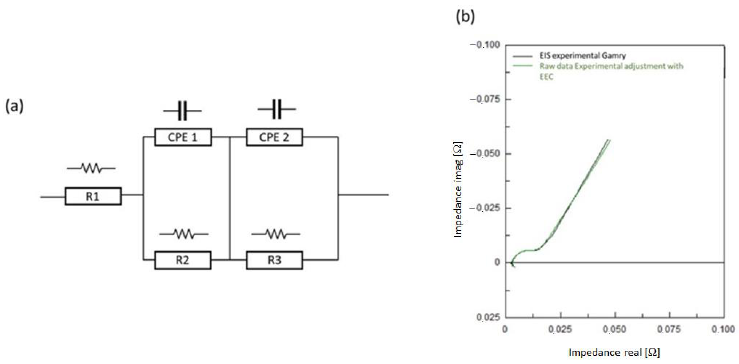
Figure 2. ( a ) Equivalent proposed EEC circuit model and ( b ) Adjustment of the EIS of the 12 V block at the 100% state of charge (SOC) using Zview software.